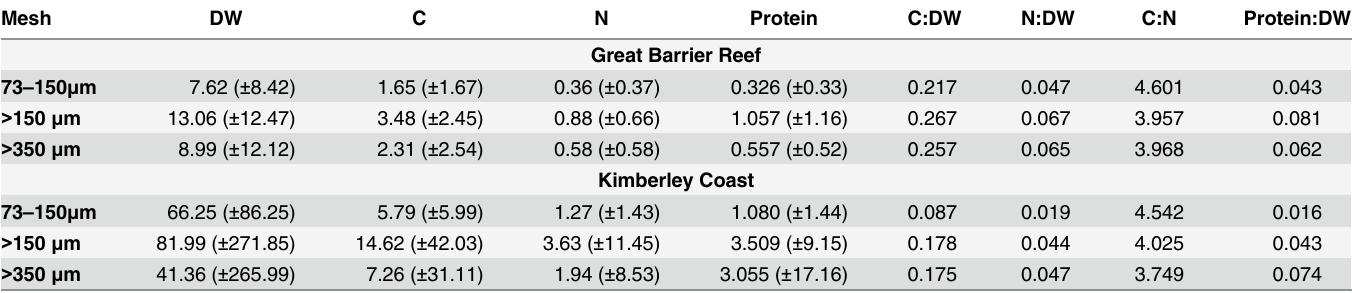
Table 2. Mean values ( ± standard deviations) of zooplankton dry weight (DW, mg m -3 ), Carbon (C, mg m -3 ), Nitrogen (N, mg m -3 ) and Protein (mg m - 3 ) aggregated over all stations in each of the three size fractions sampled by the bongo net, with their ratios by weight. Mesh DW C N Protein C:DW N:DW C:N Protein:DW Great Barrier Reef